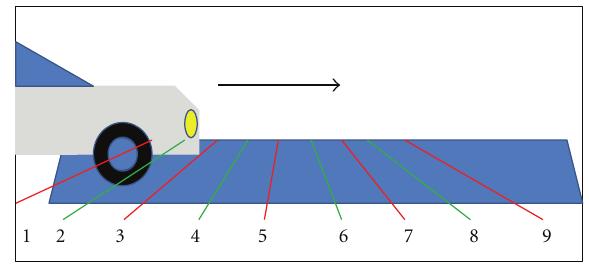
Figure 6: Characterization of vehicle speed.